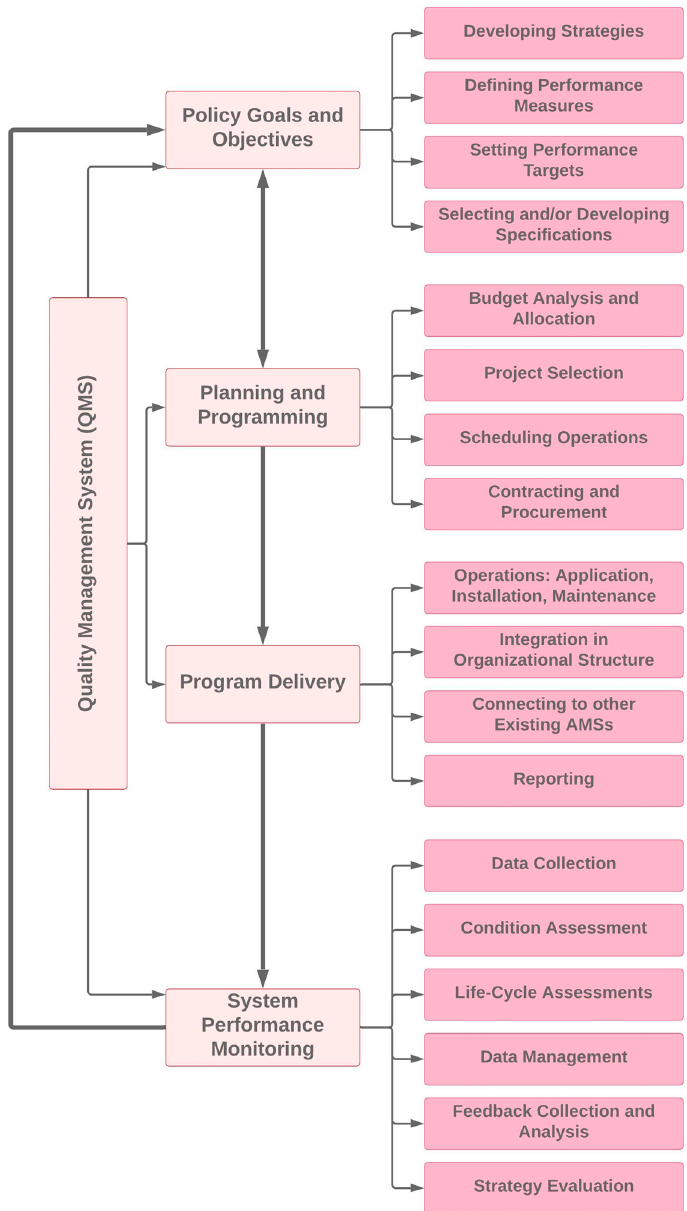
Figure 1. Key components of the pavement marking management system (PMMS) framework.